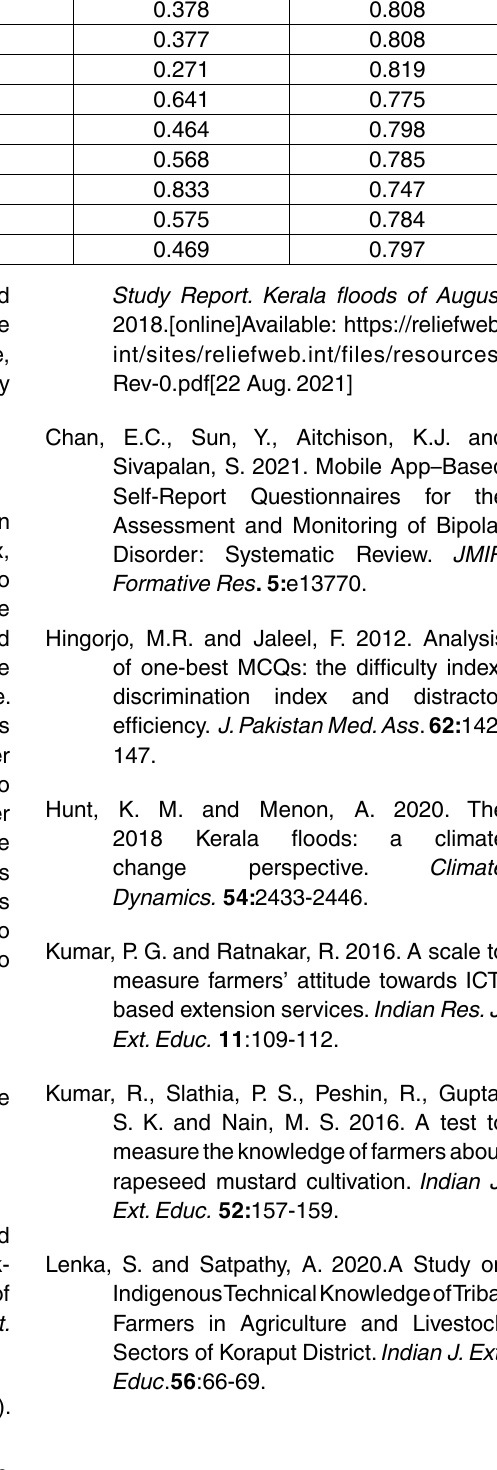
Table 2. Item total statistics